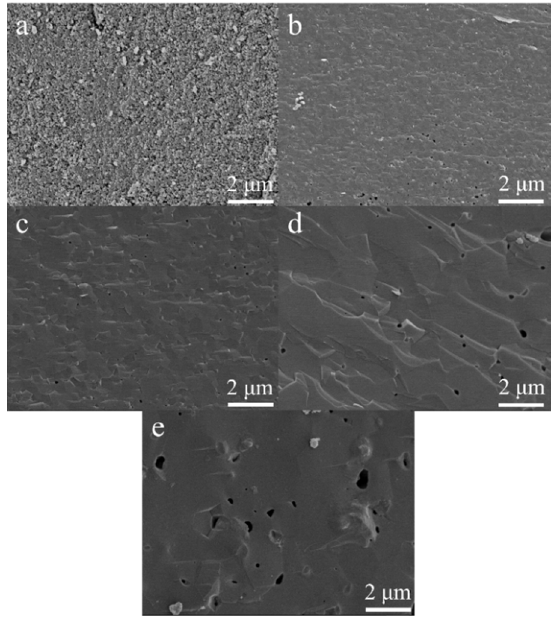
Figure 7. Cross sections of sintered HA pellets at 900 °C ( a ); 1000 °C ( b ); 1100 °C ( c ); 1200 °C ( d ); and 1300 °C ( e ). Micrographs ( a – e ) were taken at 10,000 × magnification.